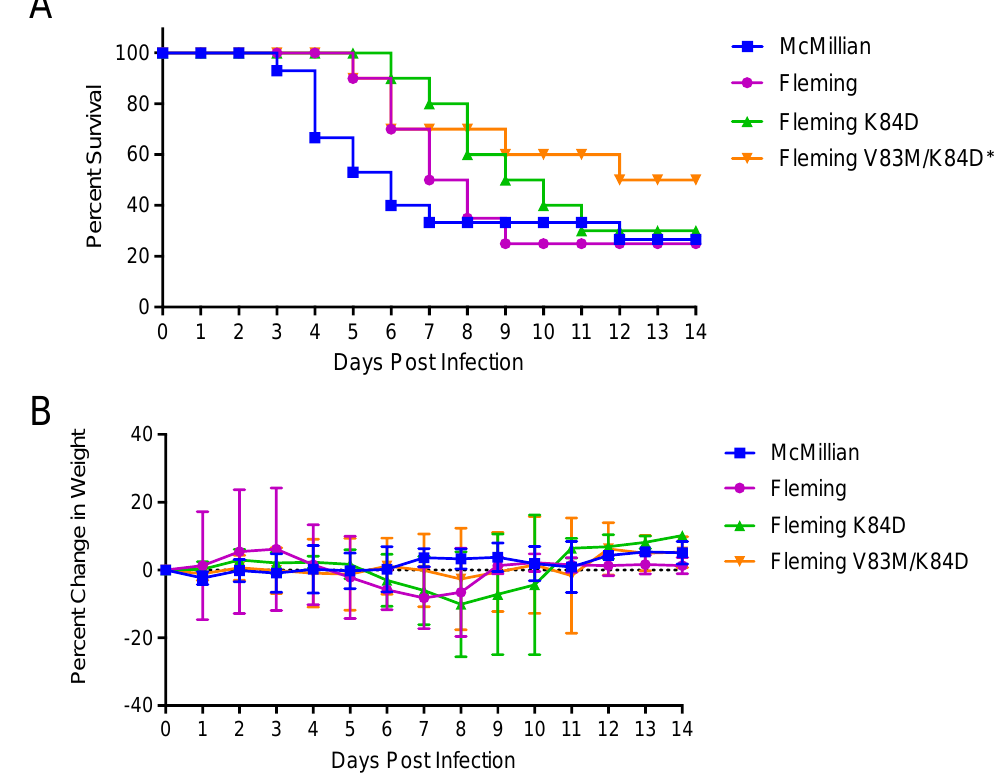
Figure 10. Survival curves ( A ) and weight loss ( B ) for 4–week–old CD–1 mice infected subcutaneously with 1000 PFU of each indicated virus. Experiments included 5 or 10 animals per group and were performed at least twice with similar results. Error bars are standard deviations. * = Survival Fleming vs. Fleming V83M/K84D p =